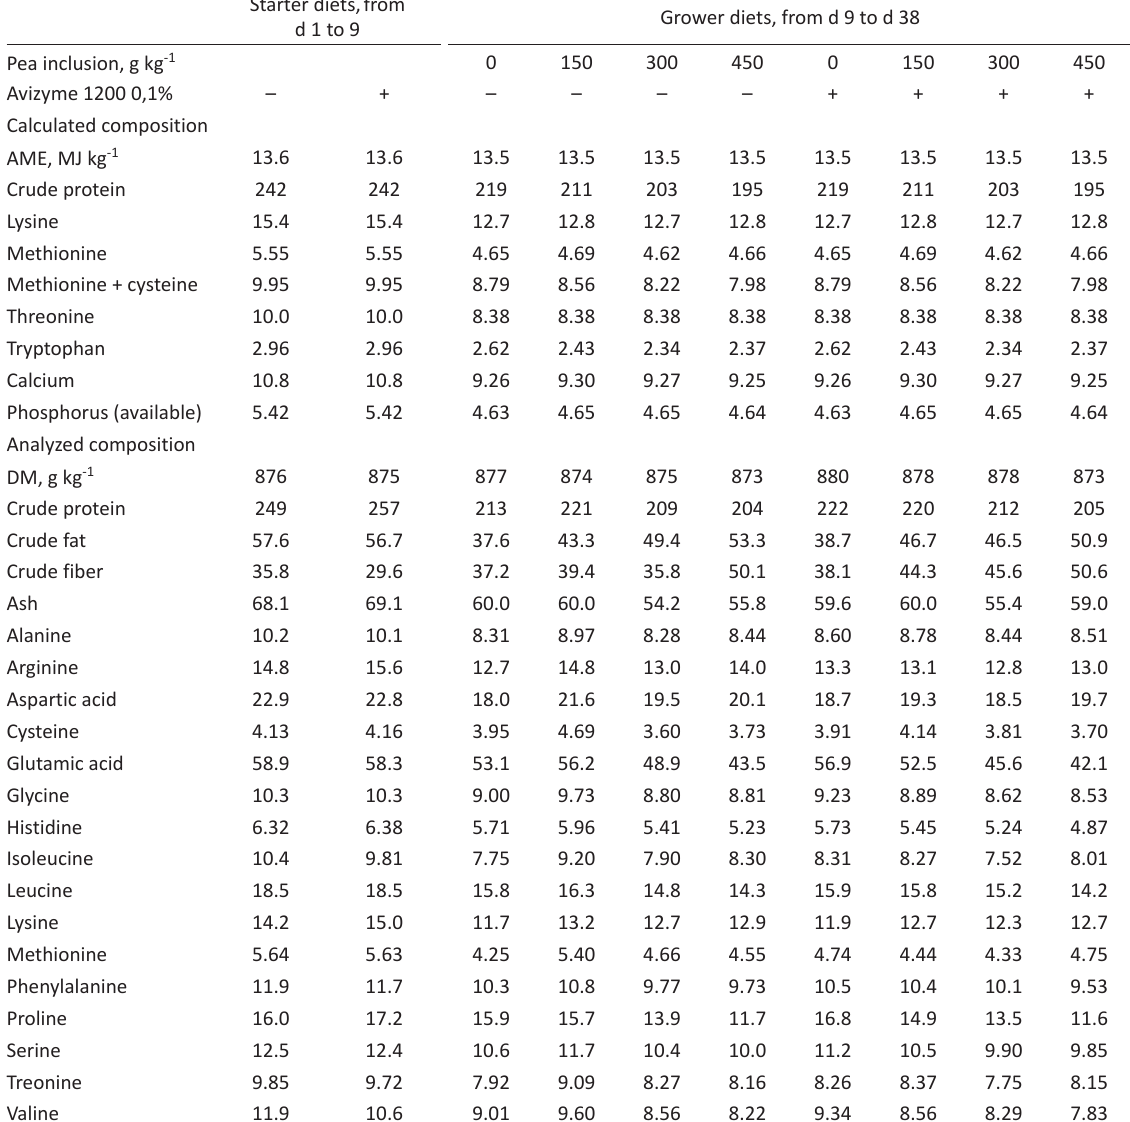
Grower diets, from d 9 to d 38